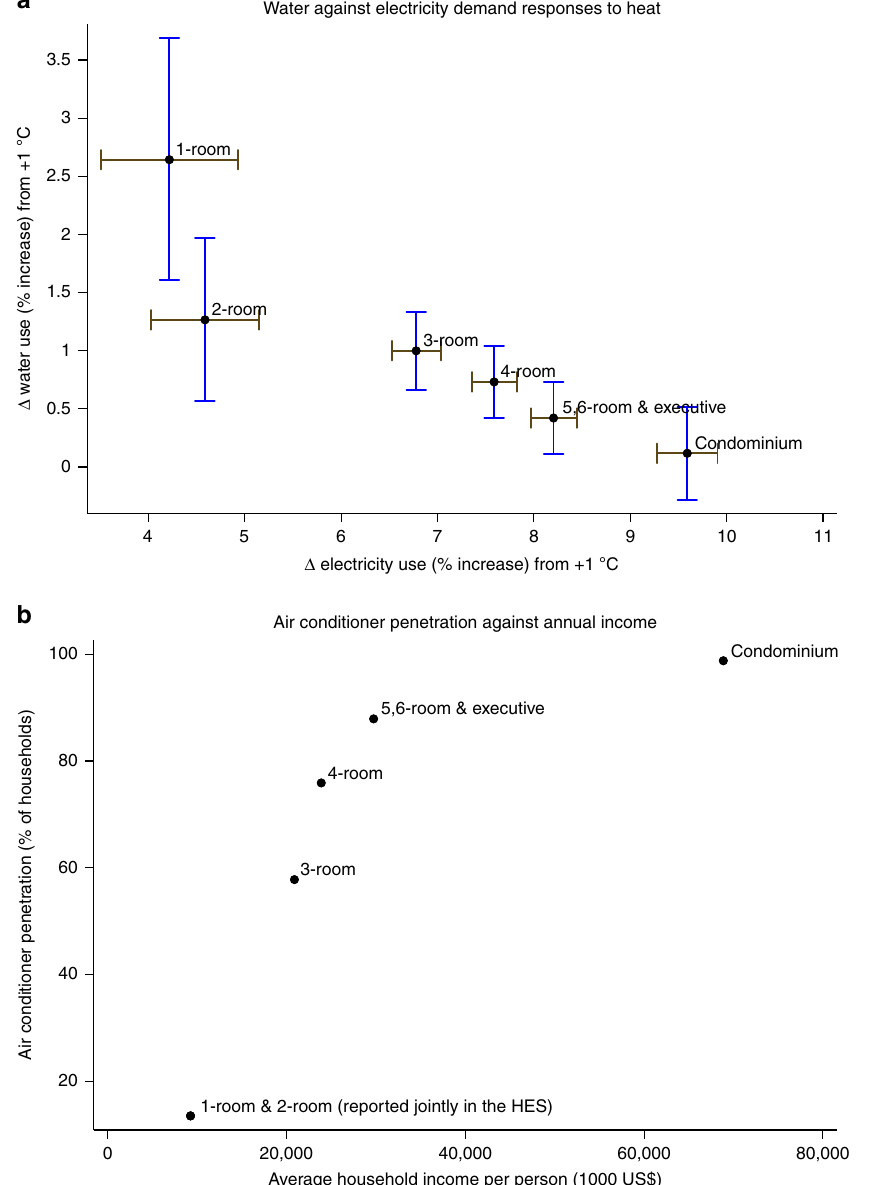
Fig. 7c, d) 52,53 . Outdoor PM 2.5 may affect the time households (Supplementary Fig. 5a). I implement models of residential precision (Supplementary Fig. 5c). I estimate Fig. 5a ’ s speci fi ca- tion by 2SLS instead of OLS, allowing PM 2.5 to be endogenous to unobserved demand shocks (Supplementary Fig. 8a, b). A further